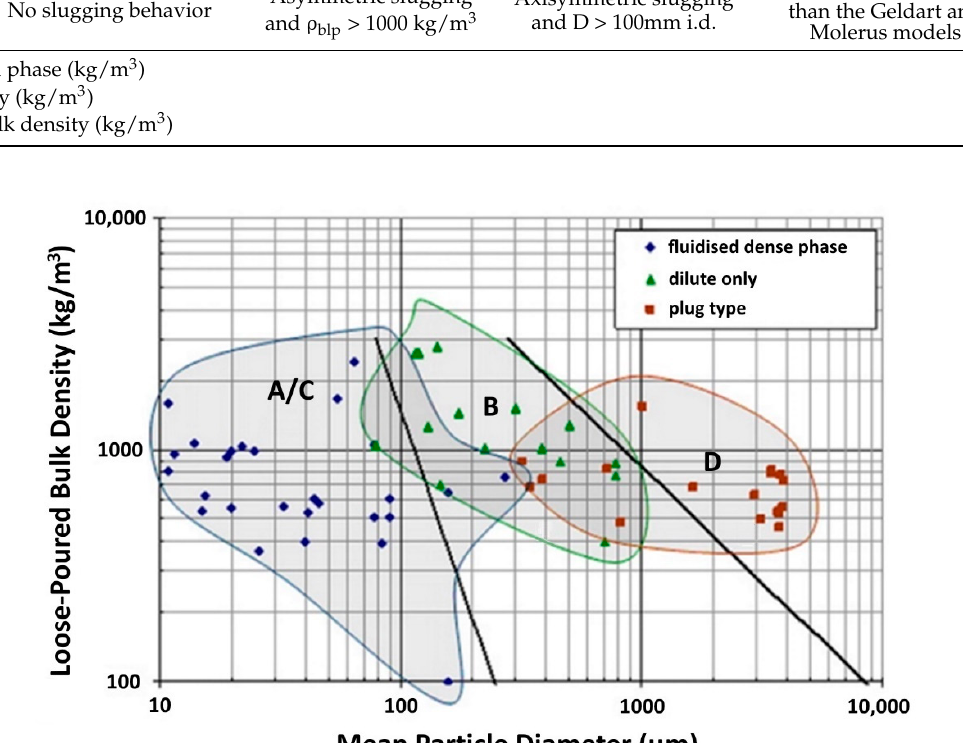
Figure 14. Modified Molerus fluidization diagram [30].